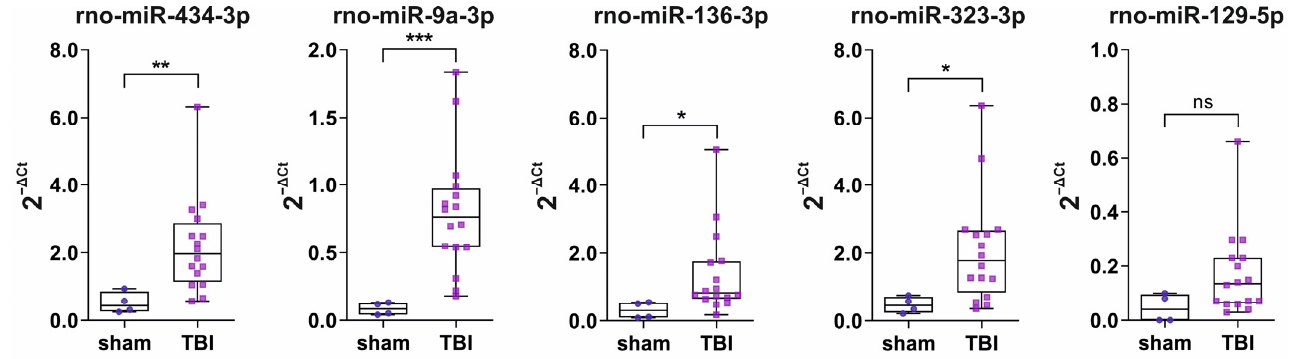
Figure 2. Technical validation of 5 plasma miRNA levels by RT-qPCR. Box and whisker plots (whiskers: minimum and maximum; box: interquartile range; line: median) showing the levels of 5 miRNAs (miR-434-3p, miR-9a-3p, miR-136-3p, miR-323-3p, and miR-129-5p) in rat plasma on D2 (48 h) after TBI or sham-operation. All of the miRNAs except miR-129-5p were upregulated in the TBI group (n = 16) compared with the sham group ( n = 4). Expression levels were normalized to the endogenous control miR-28-3p with the 2 −Δ Ct method. Statistical significance: *, p < 0.05; **, p < 0.01; ***, p < 0.001 (Mann–Whitney U test). Abbreviations: ns, not significant; TBI, traumatic brain injury.